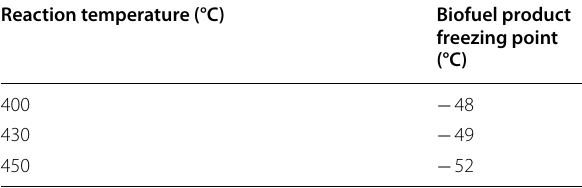
Table 3 Physicochemical properties of ZnAl BET surface area (m 2 /g)